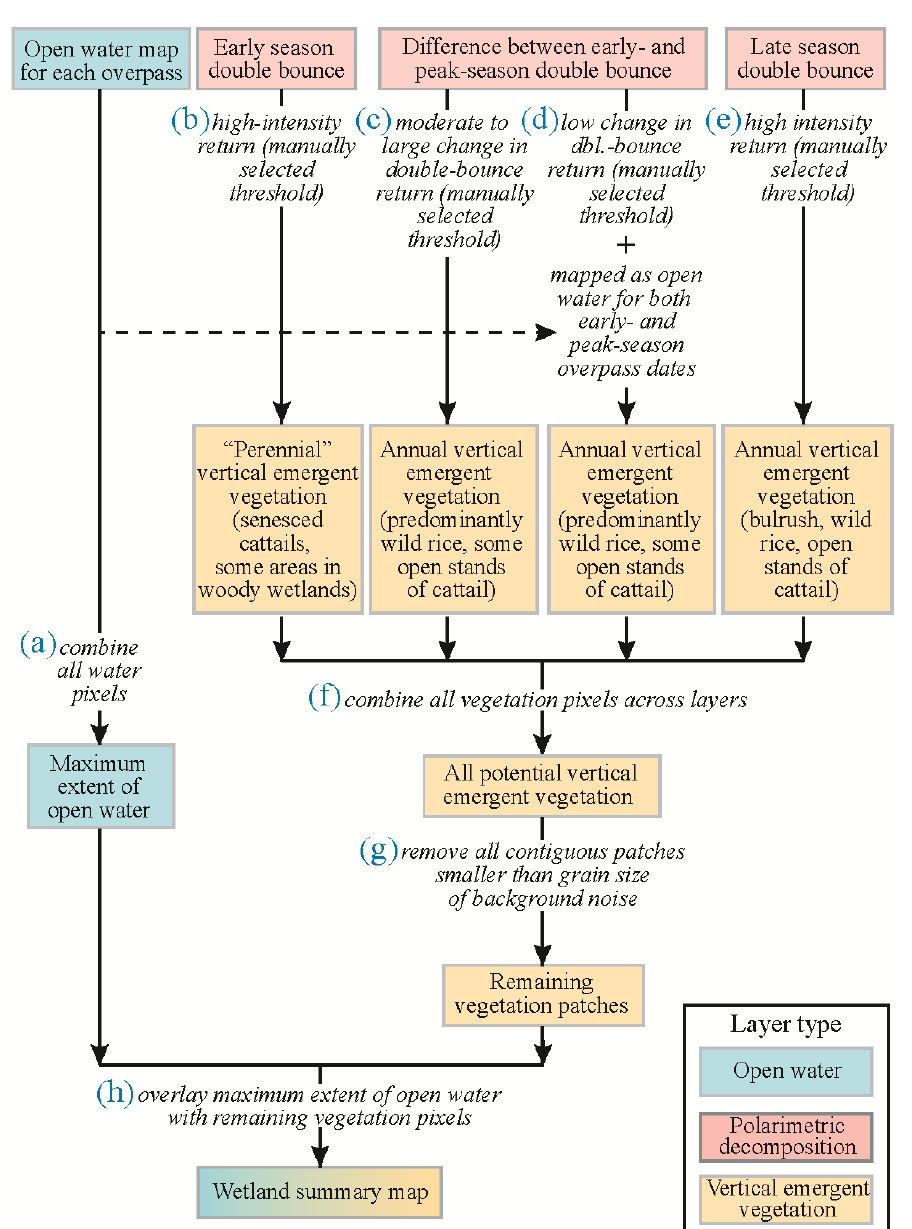
Figure 2. Processing steps to generate summary maps of wetlands for each year using only SAR